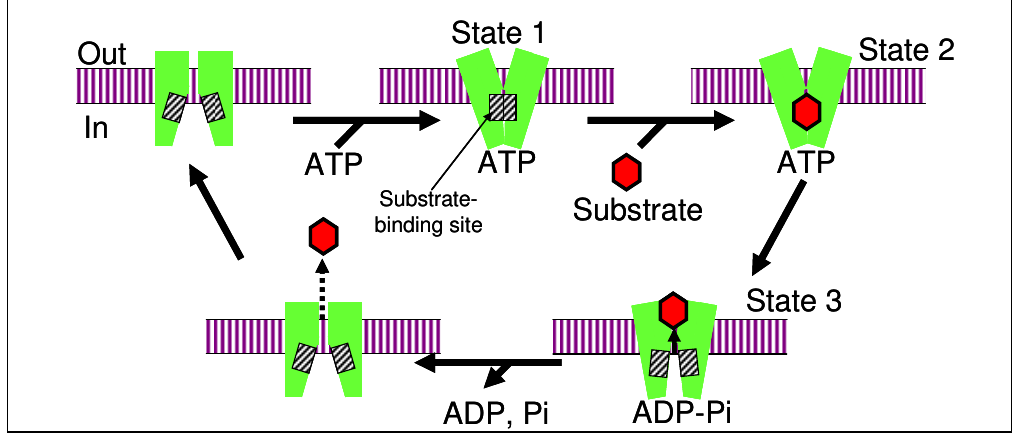
Figure 6. Schematic illustration of ATP-dependent drug transport mediated by